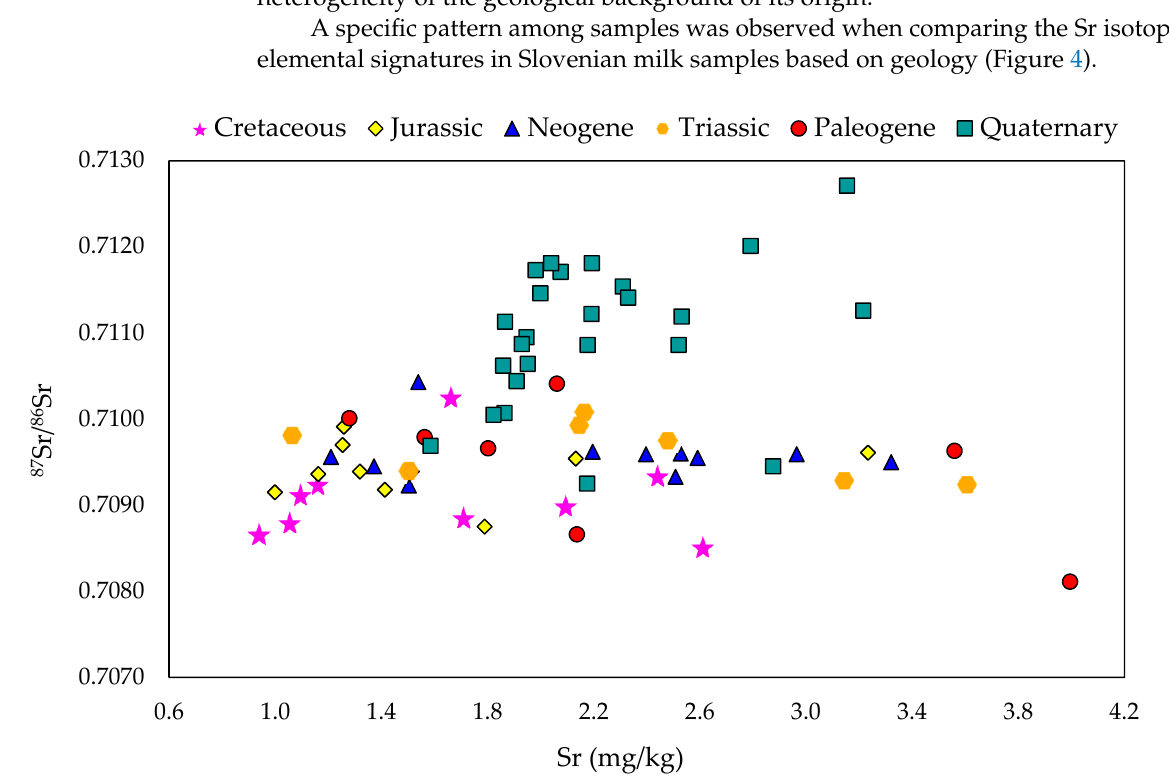
87 Sr/ 86 Sr isotope ratios in Slovenian truffles are also presented [39].